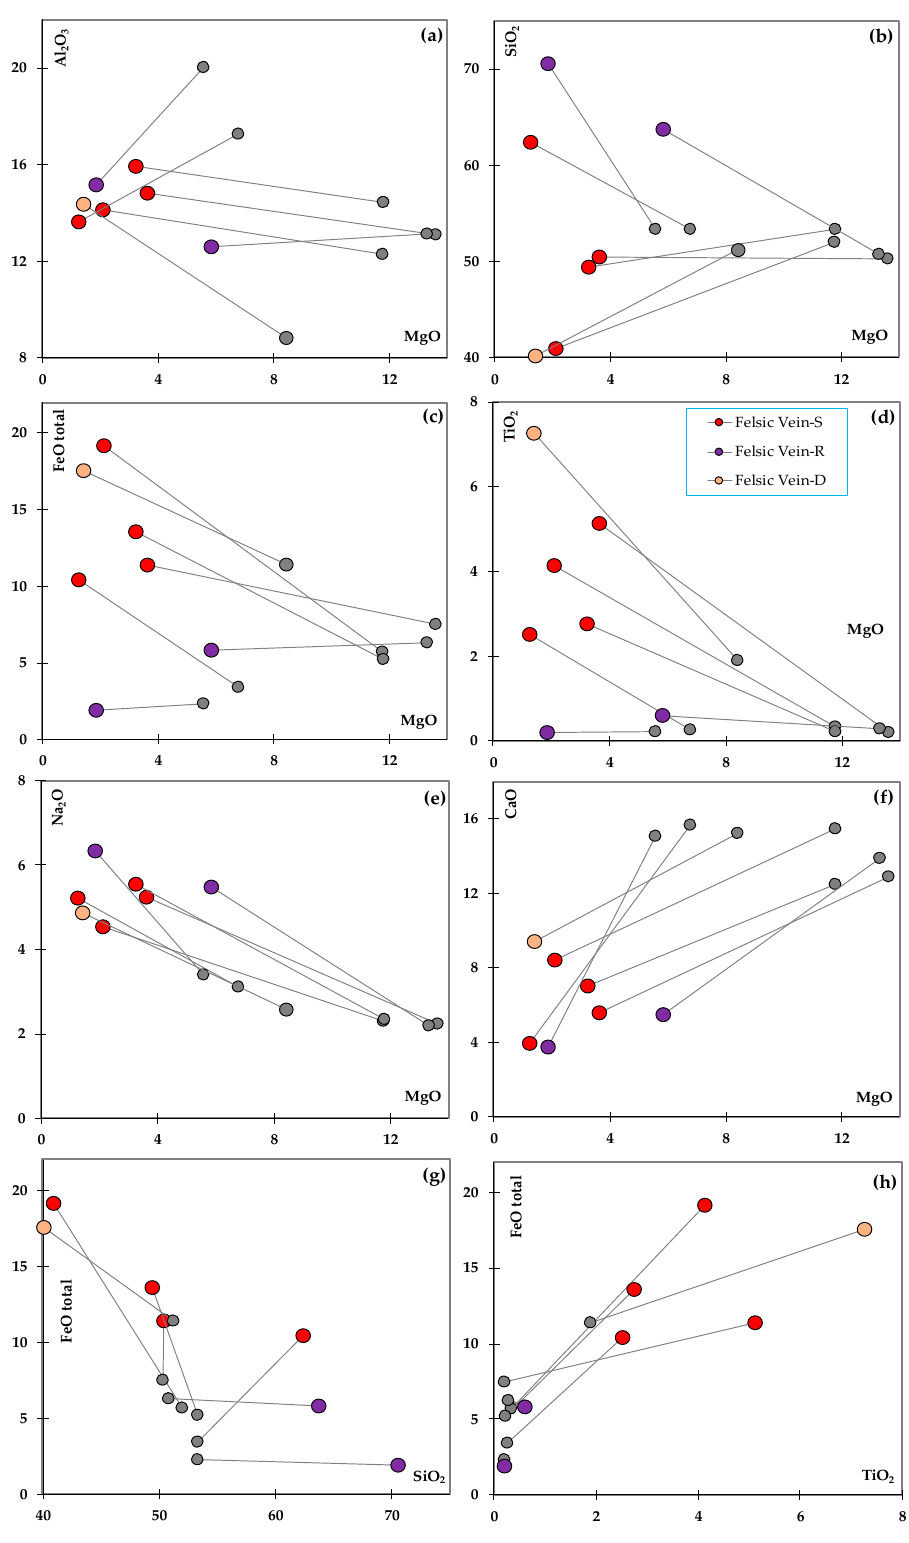
Figure 18. Variation of estimated bulk rock chemistry in wt.% of the host gabbros and felsic veins; ( a – f ) MgO versus Al 2 O 3 , SiO 2 , FeO total , TiO 2 , Na 2 O, and CaO, respectively; ( g , h ) SiO 2 and TiO 2 versus FeO total . Gray symbols are host gabbros connected with felsic veins (colorful symbols) in the same samples by gray lines.